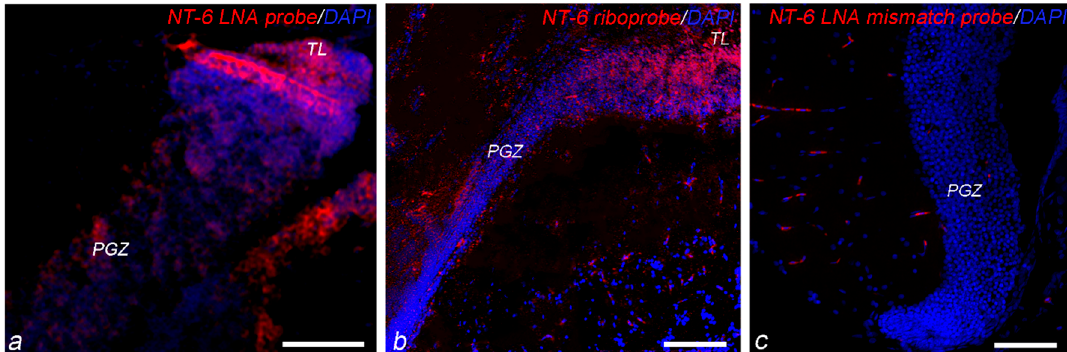
Figure 3. Comparison of riboprobe and LNA and negative control: ( a ) LNA probe and ( b ) Riboprobe to detect NT-6 mRNA expression (red) in the OT, at the margin with TL; and ( c ) mismatch LNA probe in the OT not revealing staining. Scale bar: ( a , c ) 25 µm; and ( b ) 12 µm. Abbreviations: PGZ, periventricular grey zone.